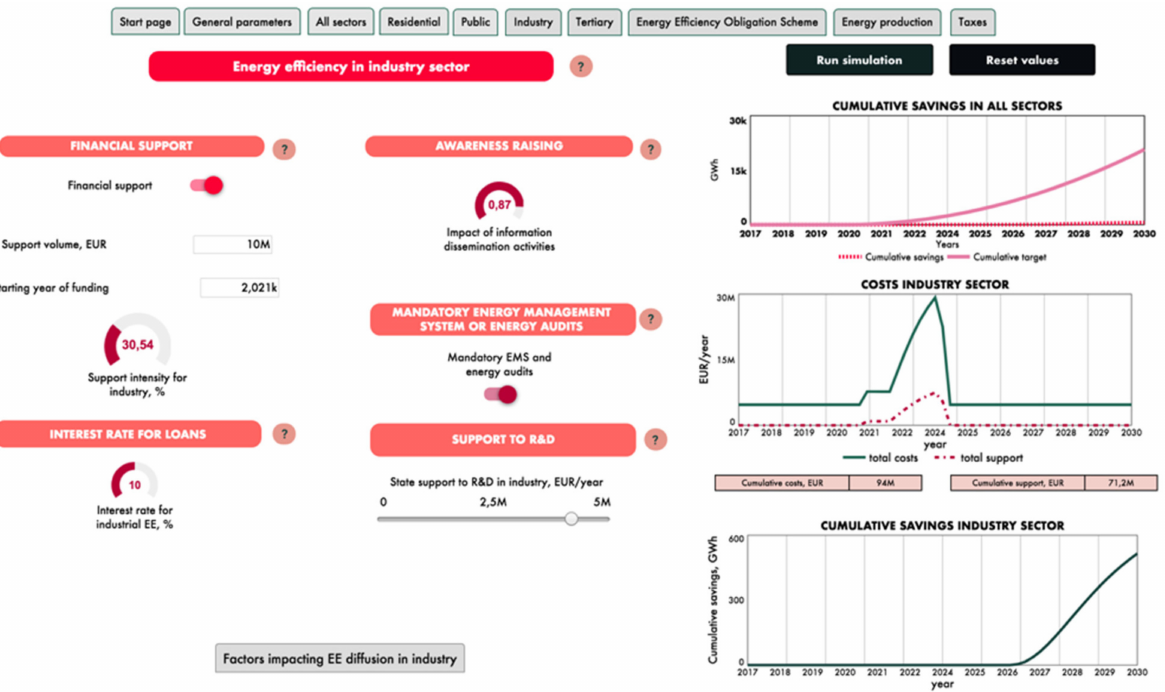
Figure A6. The first layer of Internet-based model interface for selection of policy tools for industry